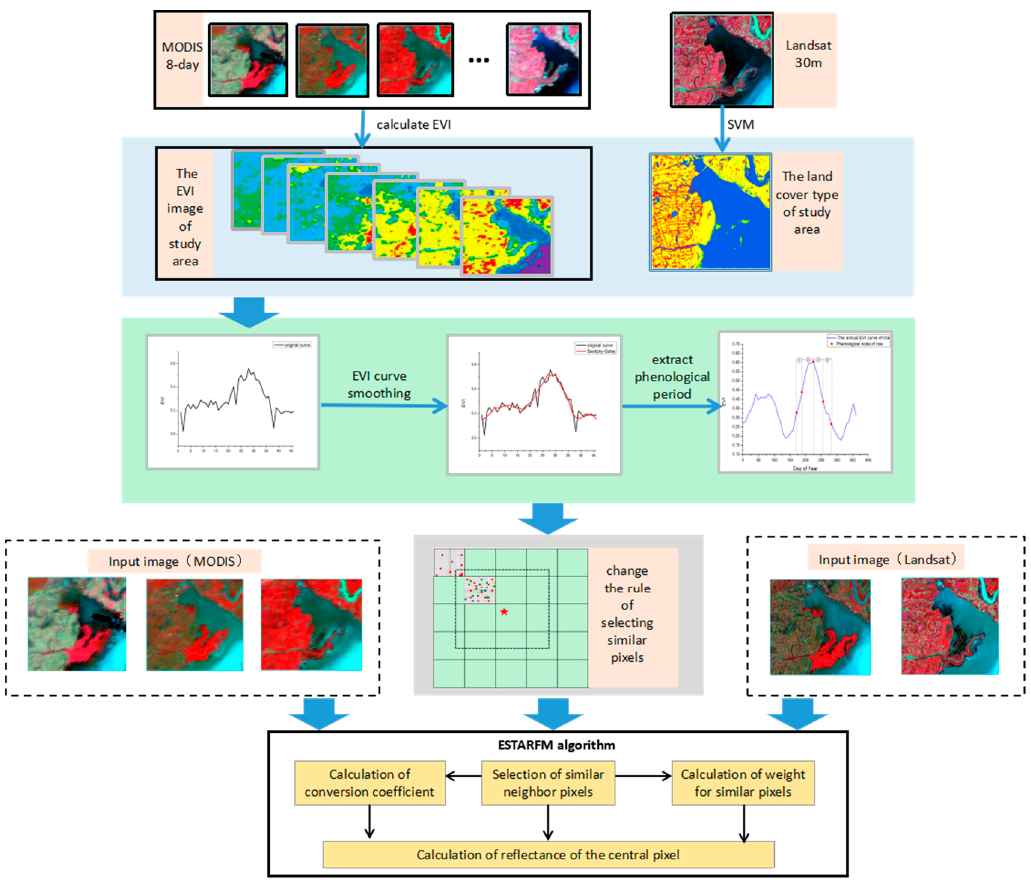
Figure 1. Framework of the modified algorithm using phenological information extracted from MODIS time series for paddy rice.